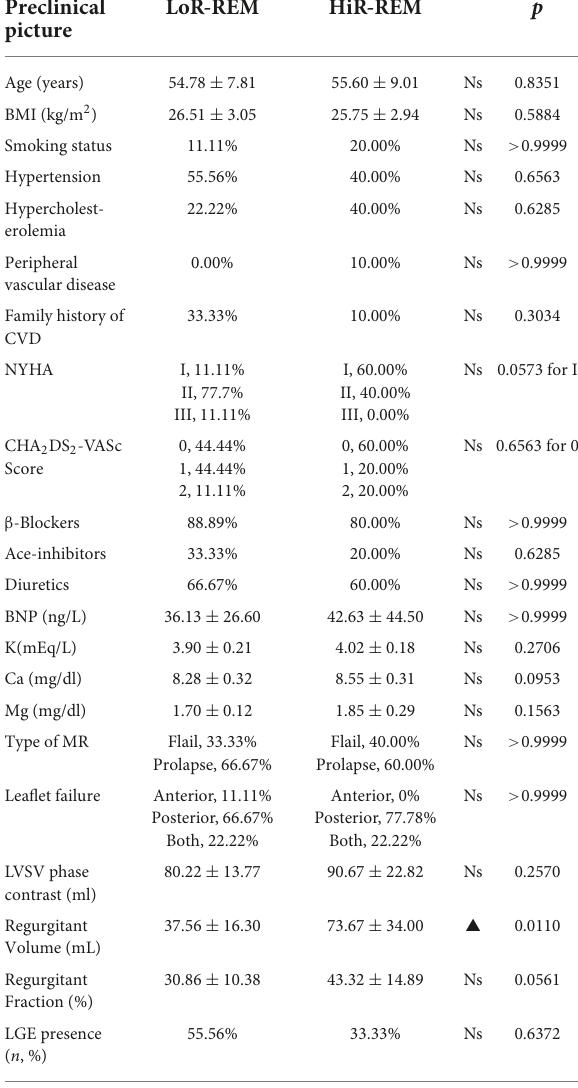
TABLE 3 Analysis of preoperative clinical parameters in MR patients with different grade of reverse remodeling after MVR surgery. Preclinical picture